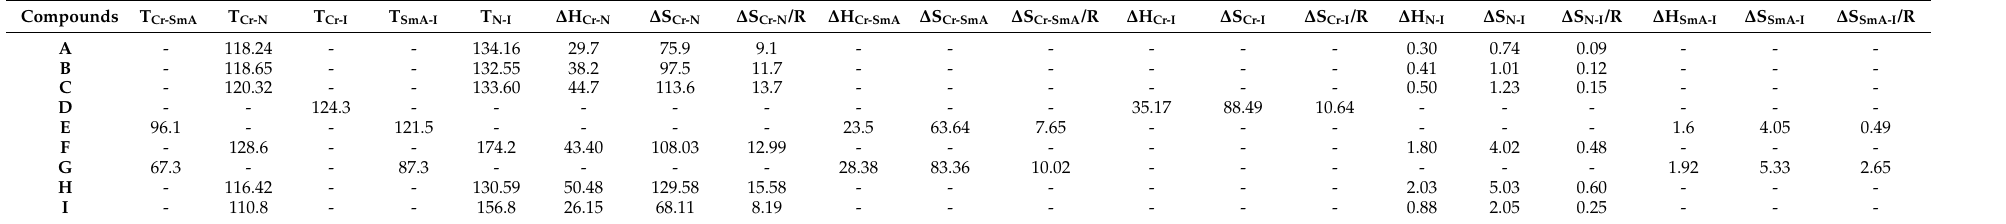
Table 1. Phase transition temperatures ( ◦ C) at 10.0 ◦ C/min, enthalpy of transition ∆ H (kJ/mol), entropy of transition ∆ S (J/mol.K), and normalized entropy